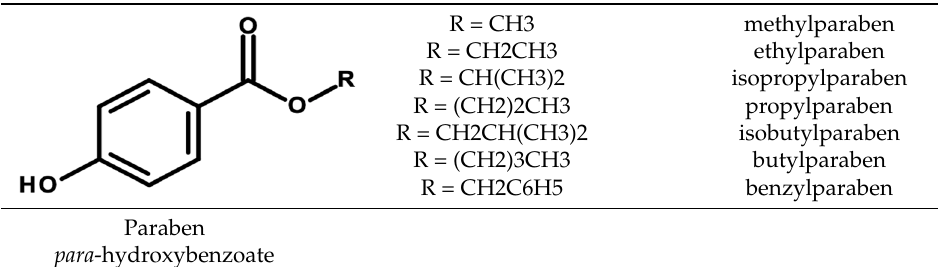
Table 5. Chemical structure of parabens.